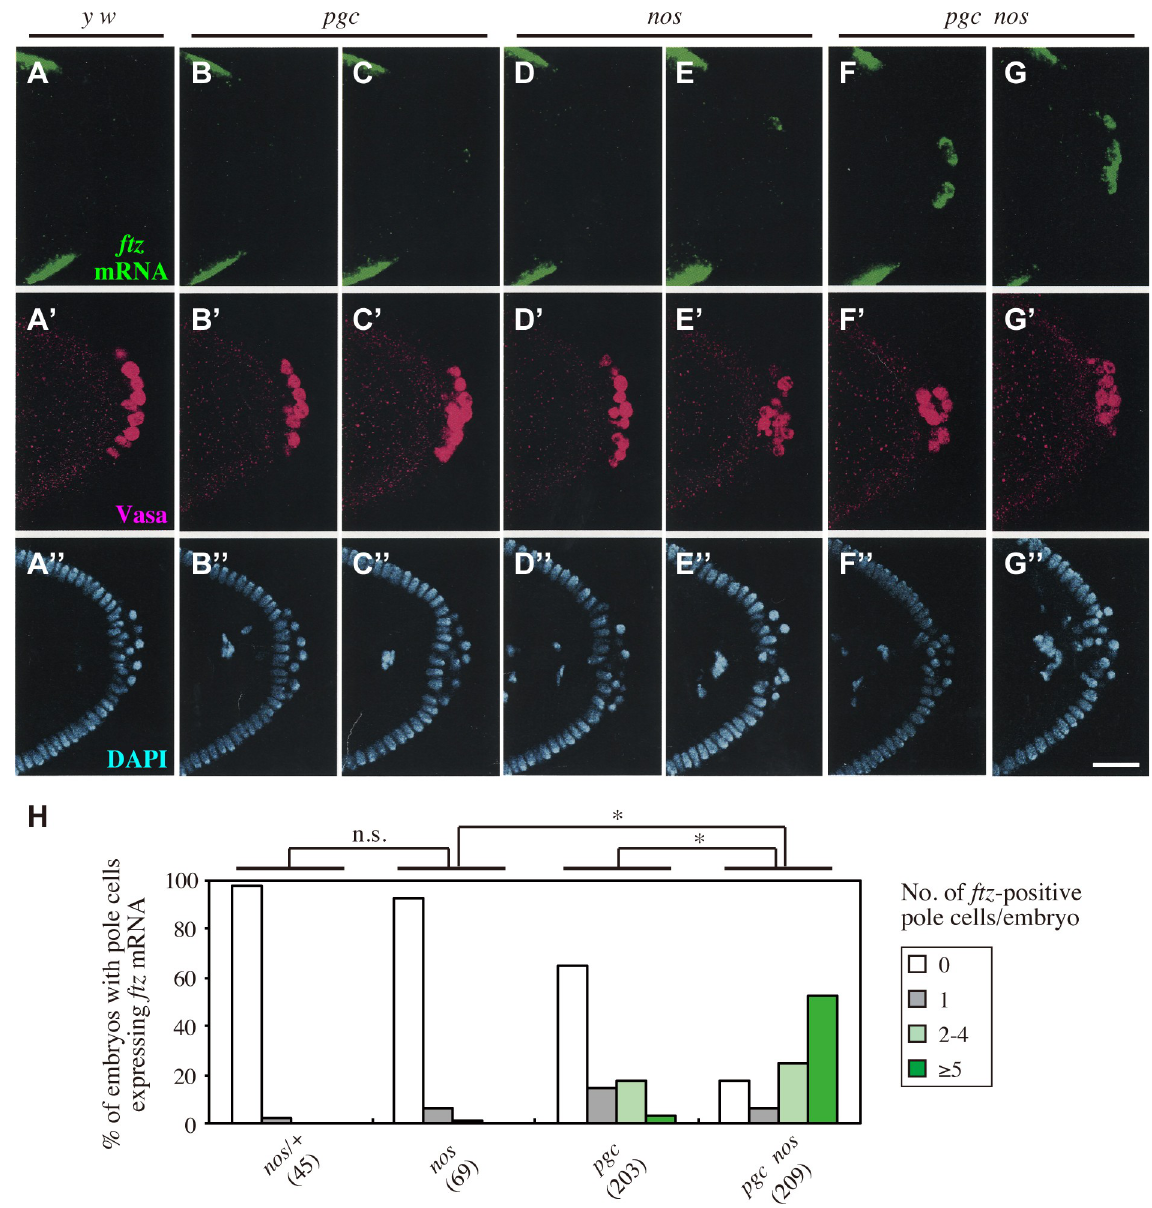
Fig 5. Nos and Pgc are both required to repress ftz expression in pole cells. ( A–G , A’–G’ , A”–G” ) ftz mRNA expression in pole cells of embryos derived from y w ( A–A” ), pgc/Df ( pgc ) ( B–B” and C–C” ), nos ( D–D” and E–E” ), and pgc/pgc ; nos/nos ( pgc nos ) females ( F–F” and G– G” ) mated with y w males. Stage-5 embryos were triple-stained for ftz mRNA (green), Vasa (magenta), and nuclear DNA (DAPI: blue). Scale bar, 30 μ m. ( H ) Expression of ftz mRNA was examined in pole cells of embryos from late stage 4 to stage 5. Embryos were derived from nos/+ , nos , pgc , and pgc nos females mated with y w males. Percentages of embryos containing 0 (white), 1 (gray), 2–4 (pale green), or � 5 (green) pole cells with ftz mRNA signal are shown. The numbers of embryos examined are shown in parentheses. Significance was calculated using Fisher’s exact test ( � : P < 0.01, n.s.: P >